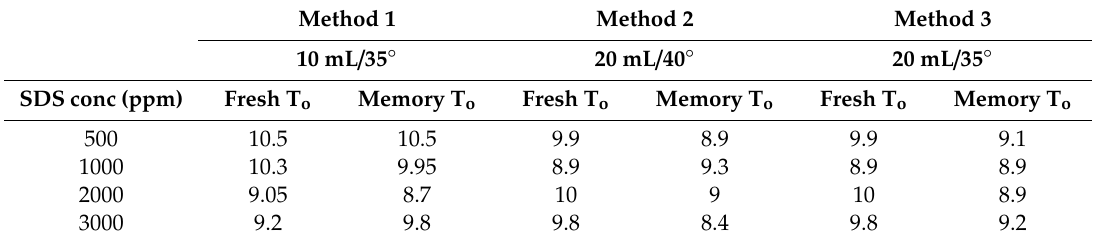
Table 1. Summary of the three attempted methods and different rocking angle and solution volume configurations.